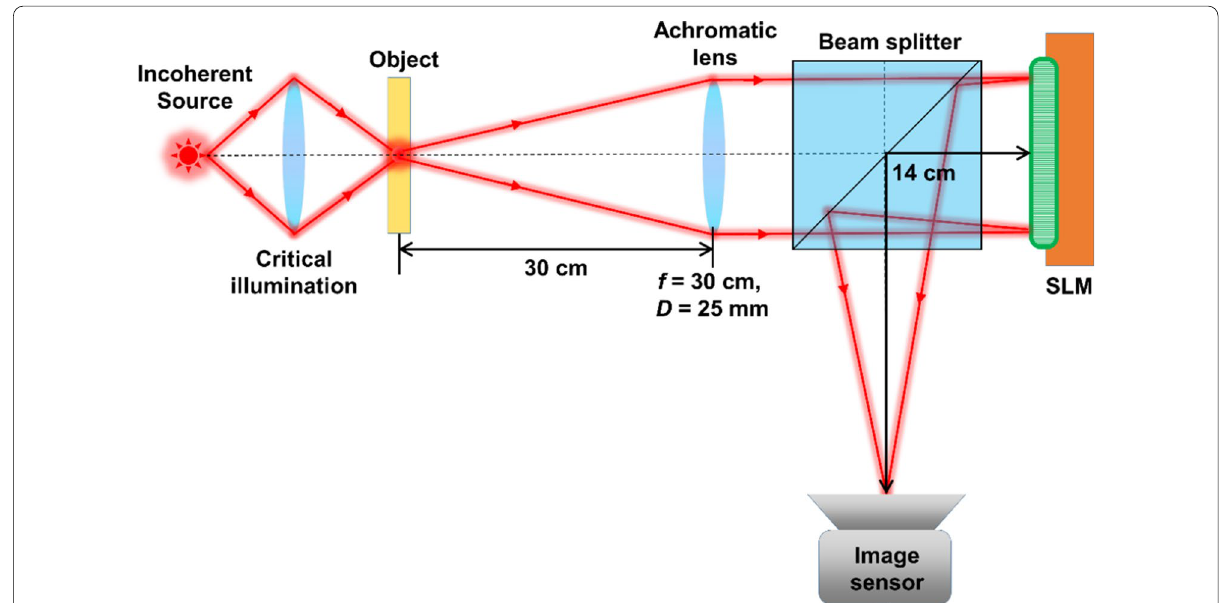
Fig. 8 Schematic of the experimental setup. SLM—Spatial light modulator; f —focal length and D —diameter of the